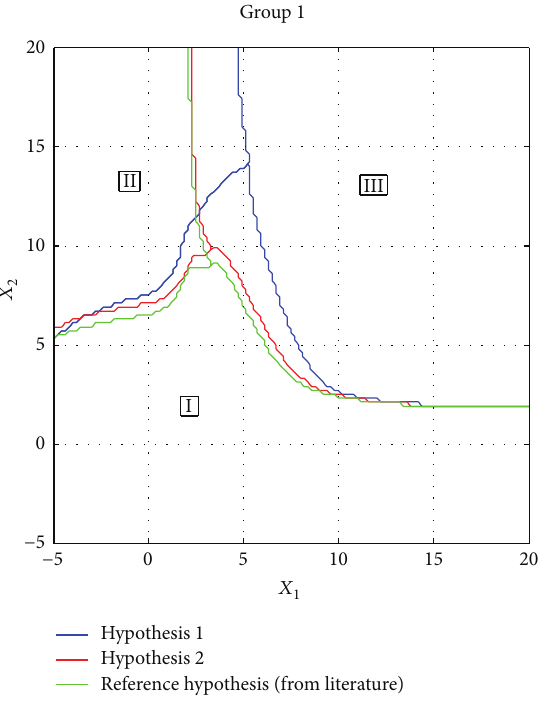
Figure 10: Setup policy (product 1 to product 2).